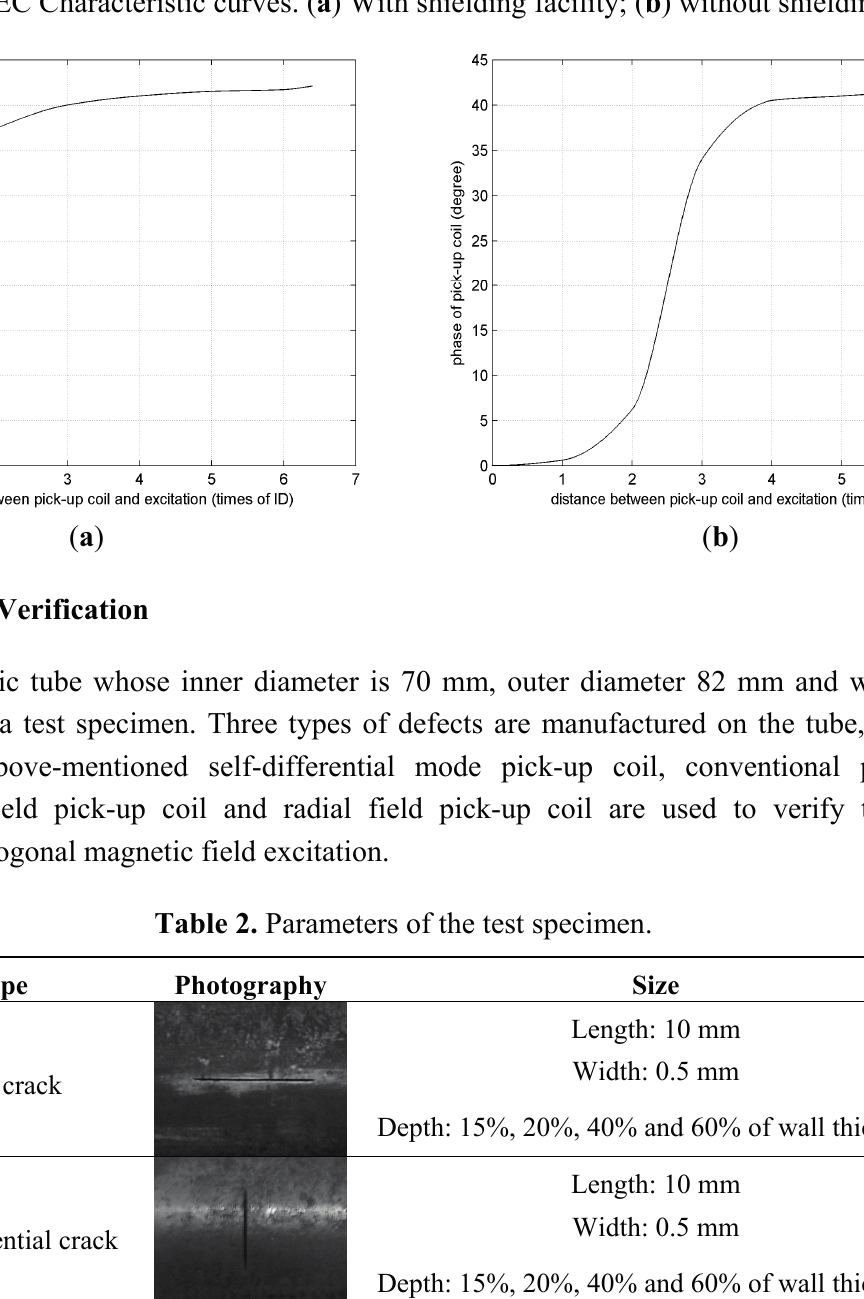
Figure 16. RFEC Characteristic curves. ( a ) With shielding facility; ( b ) without shielding facility.